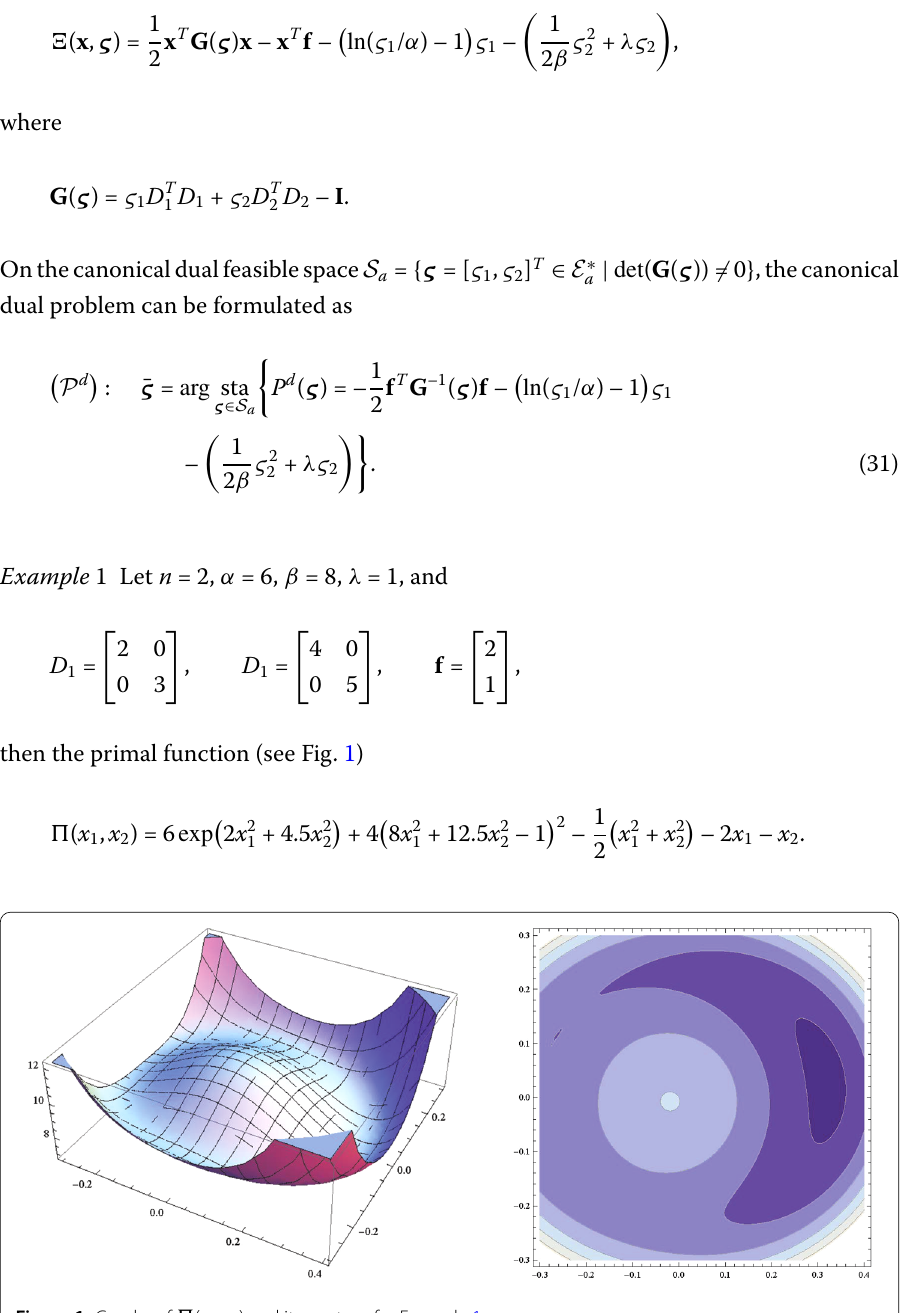
Figure 1 Graphs of (cid:2) ( x 1 , x 2 ) and its contour for Example